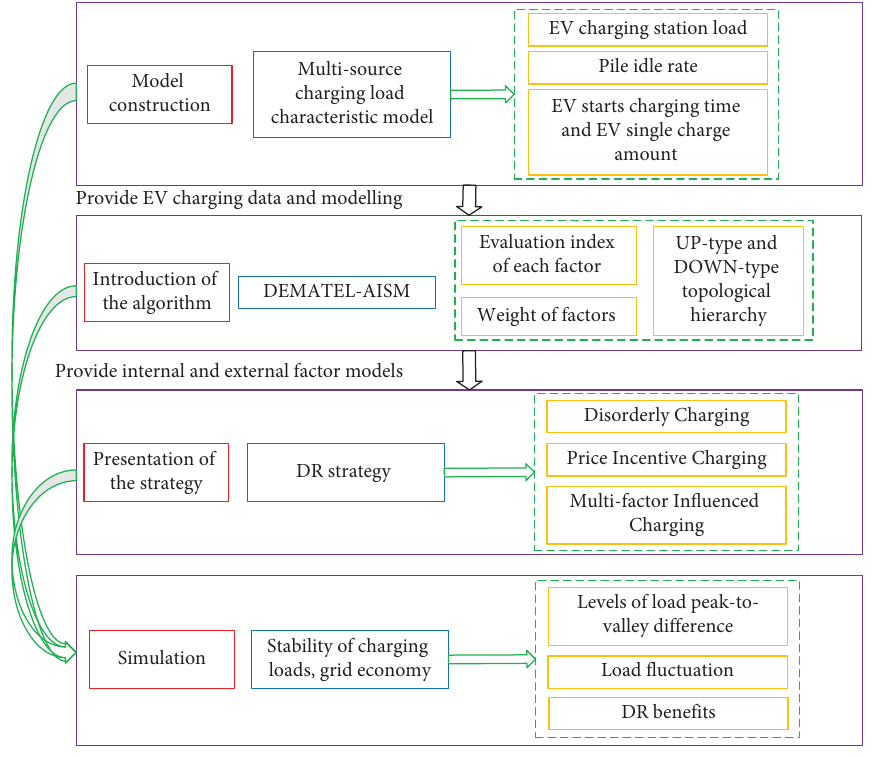
Figure 1: Overall process block